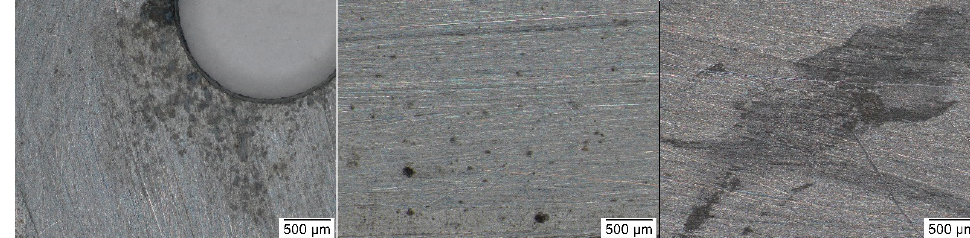
Figure 7. Total color difference of zinc corrosion coupons after 1, 3, and 30 months of exposure.